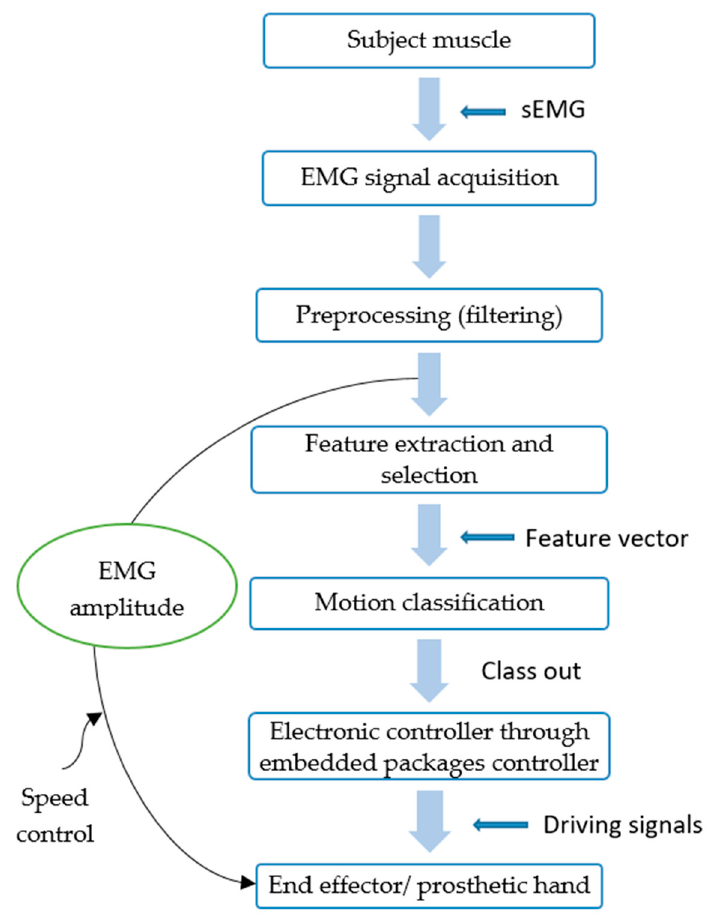
Figure 3. Real-time EMG-PR with embedded system.